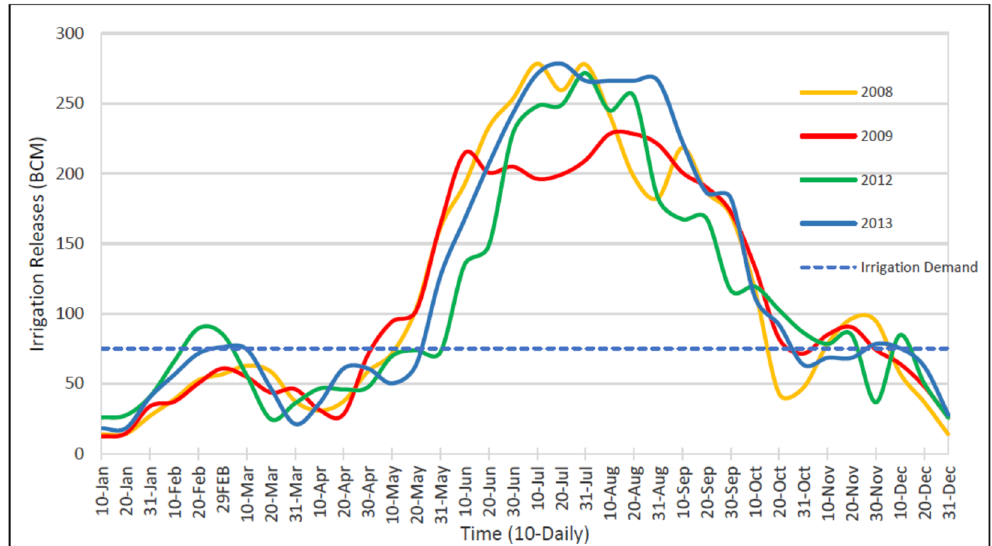
Figure 9. Irrigation Releases from Tarbela Reservoir.